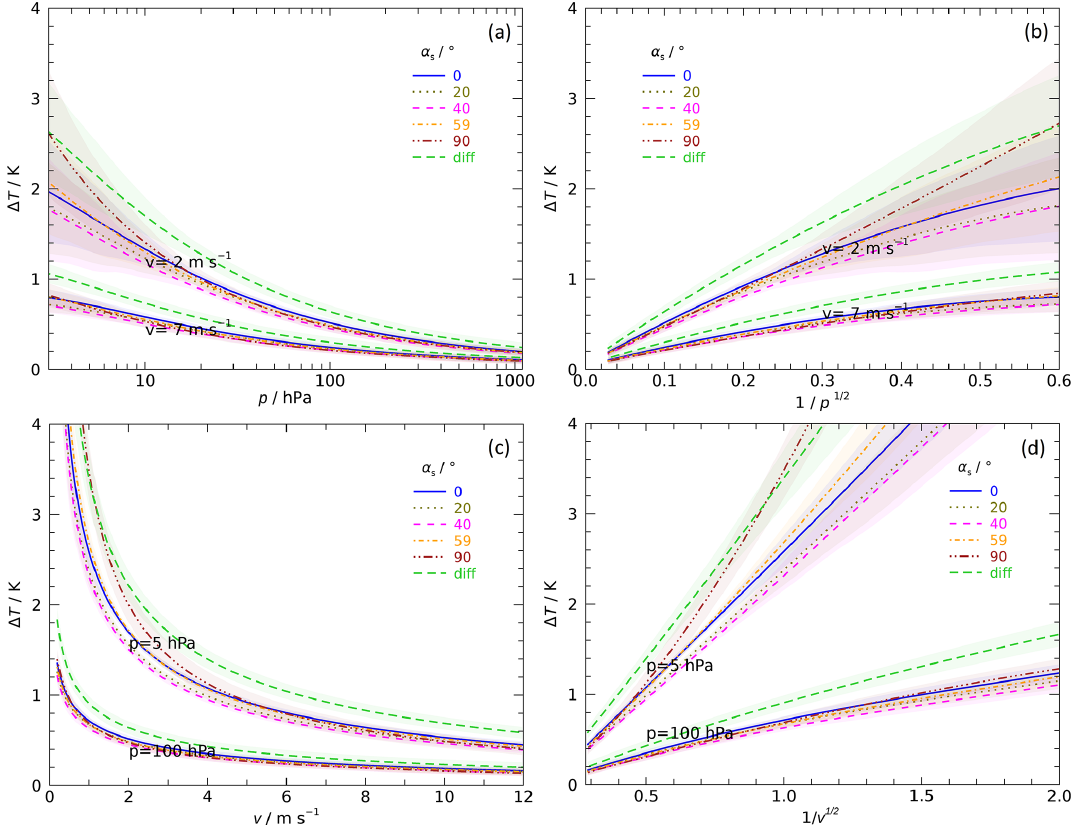
Figure 14. Solar temperature error for various radiation incidence angles ( α s ). (cid:49)T from Eq. (5) is normalised, i.e. linearly scaled, for each α s to an irradiance equivalent to the solar constant (1361Wm − 2 ) beforehand. Upper row: examples for ventilation levels of 2 and 7ms − 1 ; (a) pressure as x axis; logarithmic scale for better visibility; (b) plot vs. 1 /p 1 / 2 . Lower row: examples for pressure levels of 5 and 100hPa; (c) ventilation as x axis; (d) plot vs. 1 /v 1 / 2 . Shaded areas around the graphs denote 1 σ -uncertainty